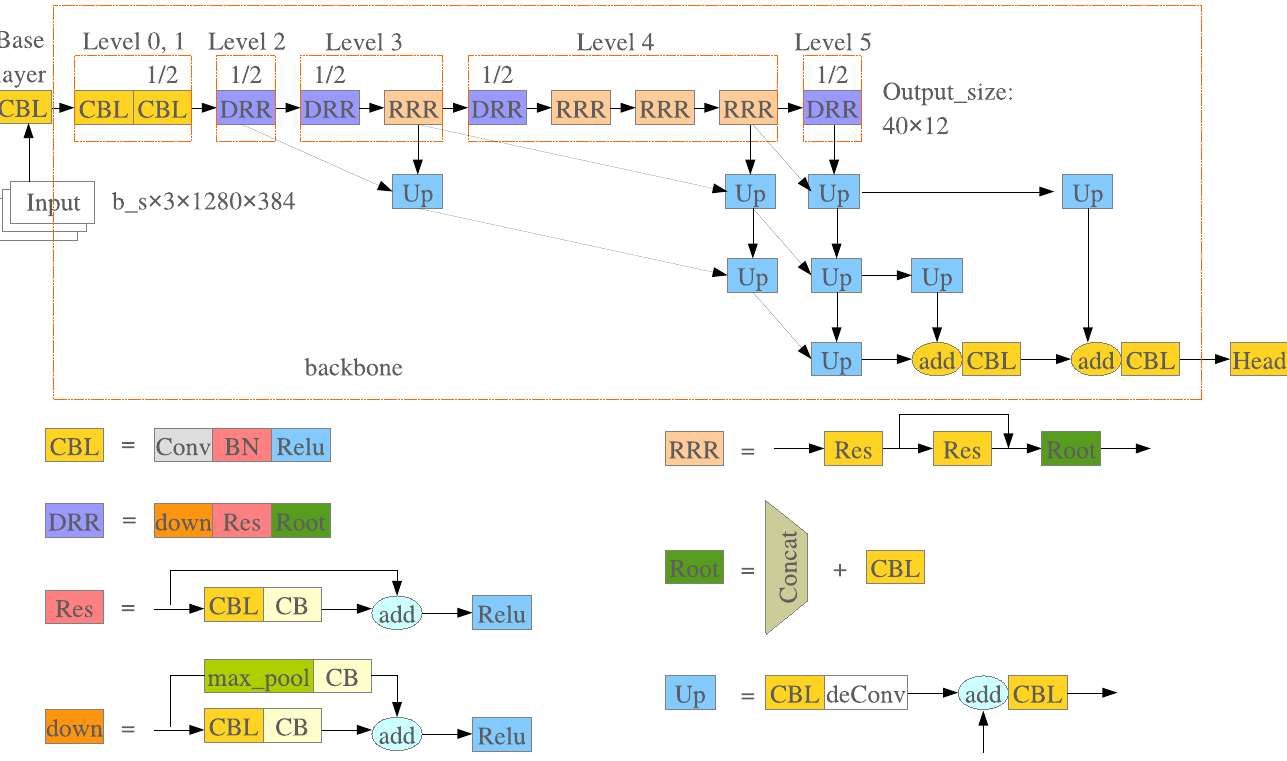
Figure 5. Semi-aggregation DLA-34 (SADLA-34) backbone structure. SADLA-34 can be divided into L 0– L 5 levels and the iterative deep aggregation structure. We summarized each repetitive module and represented as ’CBL’, ’DRR’, and ’RRR’, which can be further split into basic network units.